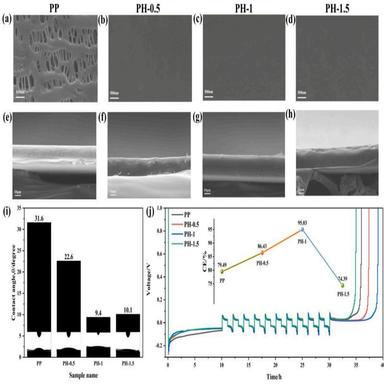
(a)-(d) surface morphology, (e)-(h) cross-section morphology, and (i) Contact angle measurements of PP and PH-x; (j) Coulombic efficiency measures of Cu-Li cells with PP or PH-x.